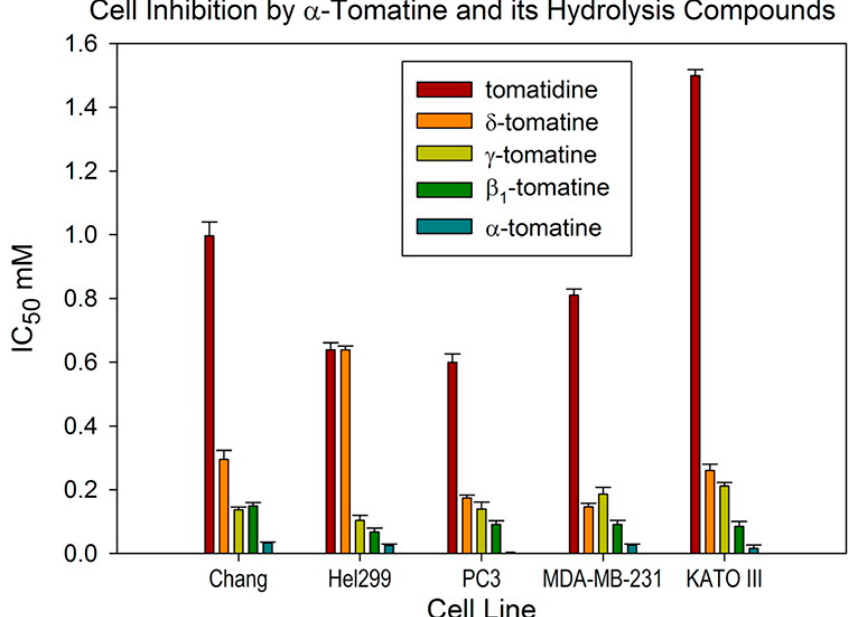
Figure 2. IC 50 values determined for α -tomatine, β 1 -tomatine, γ -tomatine, δ -tomatine, and the aglycone tomatidine against cancer cells lines PC3 (prostate), MDA-MB-231 (breast), and KATO III (gastric). Chang cell line is normal human liver, and HeI299 is normal human lung cells. The MTT cell viability assay was applied after 48 h. Reproduced from reference [54] with permission, copyright 2012 American Chemical Society.